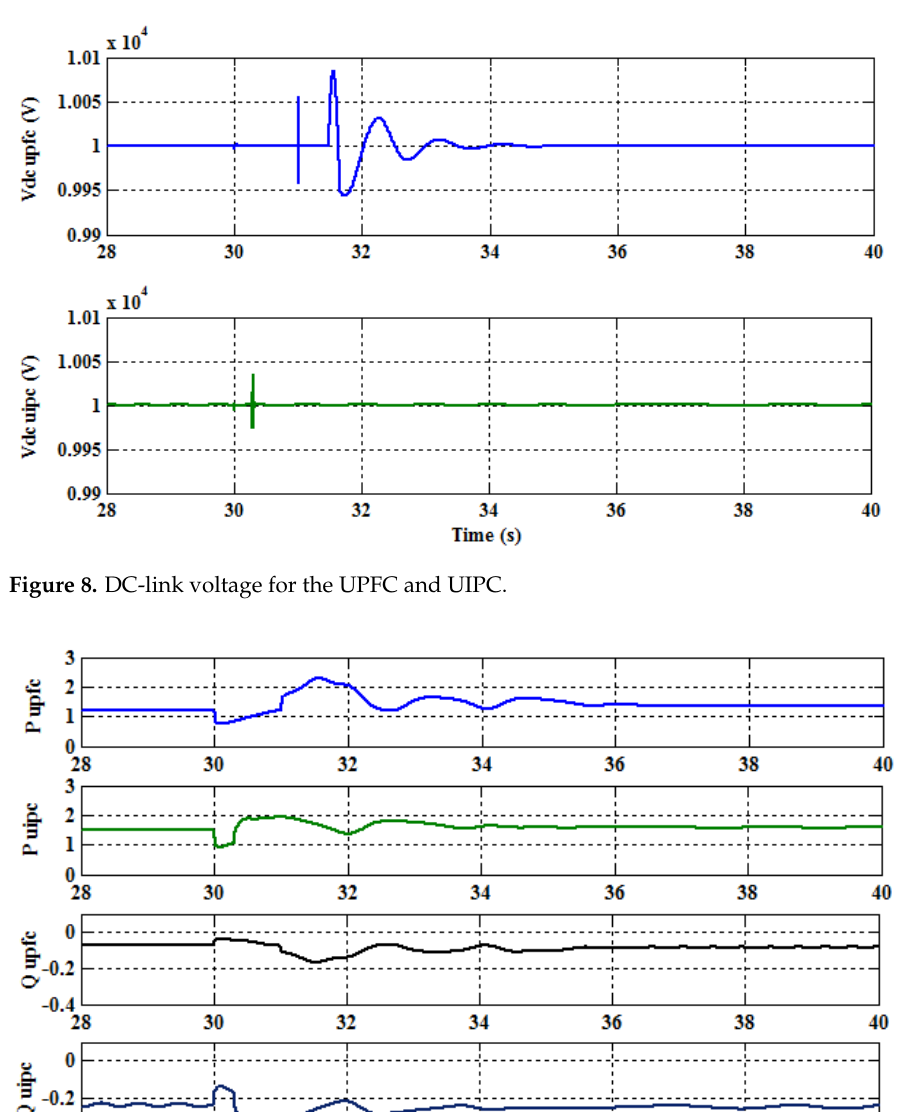
Figure 10. The output voltage of the UPFC and UIPC at the connection point.